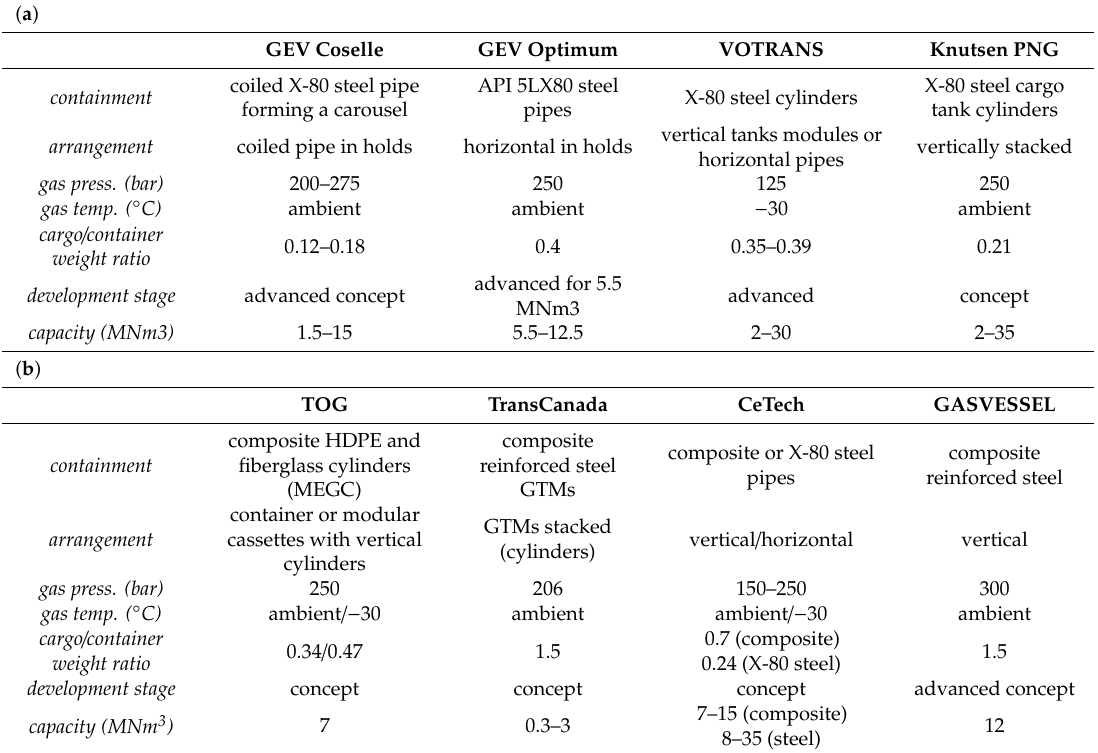
Table 1. CNG vessel technologies, part